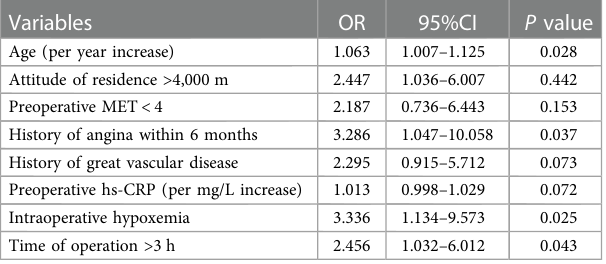
TABLE 4 Clinical factors included in the PCCs prediction model.